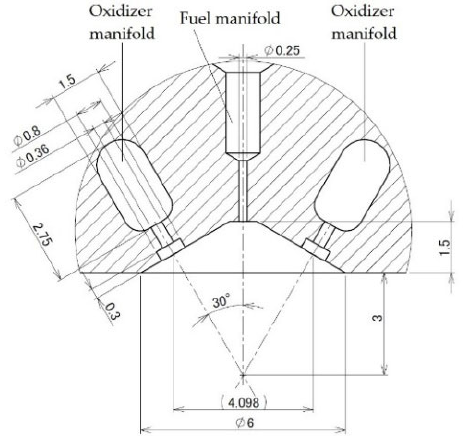
Figure 8. Schematic drawing of the injection hole section. Table 4. Design specifications of the injector.